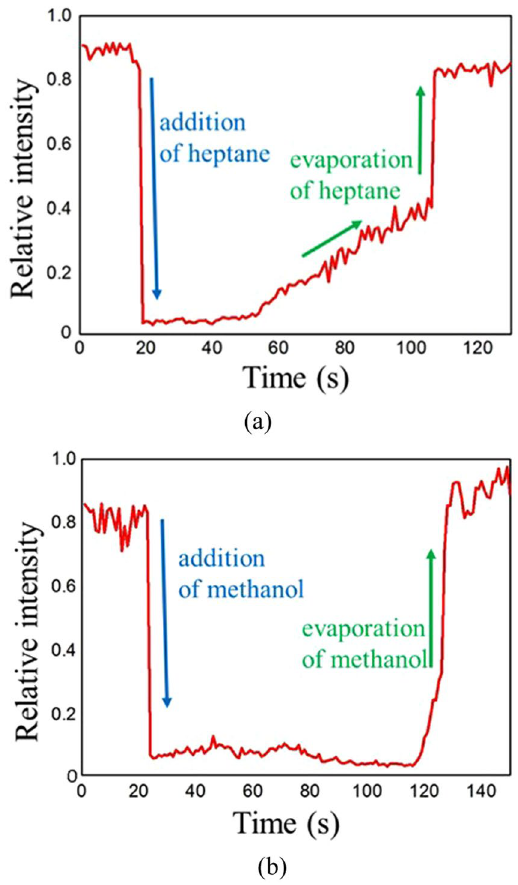
Figure 4. Real-time detection of ( a ) heptane and ( b ) methanol using mid-IR waveguide sensors at λ = 3.1 µ m and 2.9 µ m, respectively. The mode intensity decreased when the analytes were dropped on the waveguide surface and then recovered when the analyte evaporated.